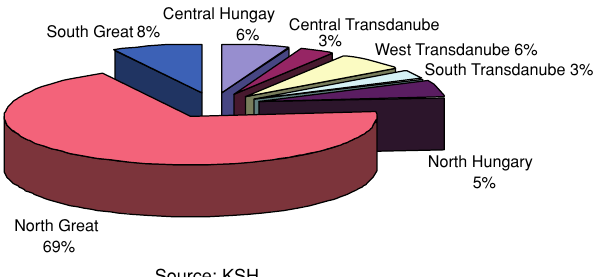
Figure 4: Regional distribution of apple growing in Hungary (means of